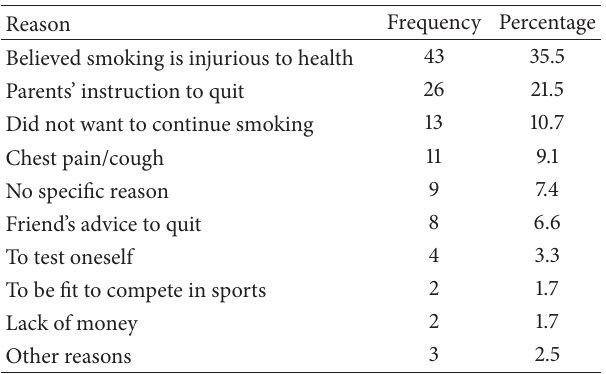
Table 1: Perceived reasons behind attempt to quit smoking ( 𝑛 = 121 ).